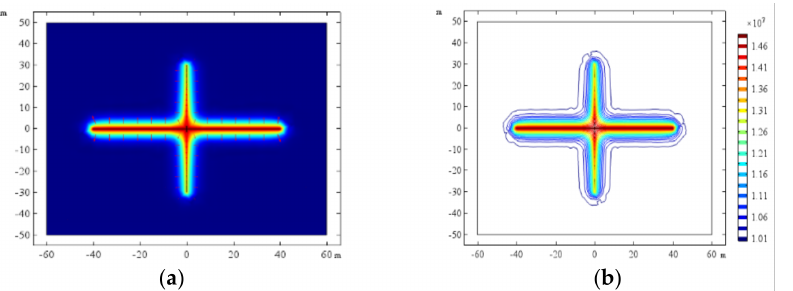
Figure 7. Case 4 calculation result. ( a ) Grout propagation pattern. ( b ) Distribution of grout propaga- tion pressure field.